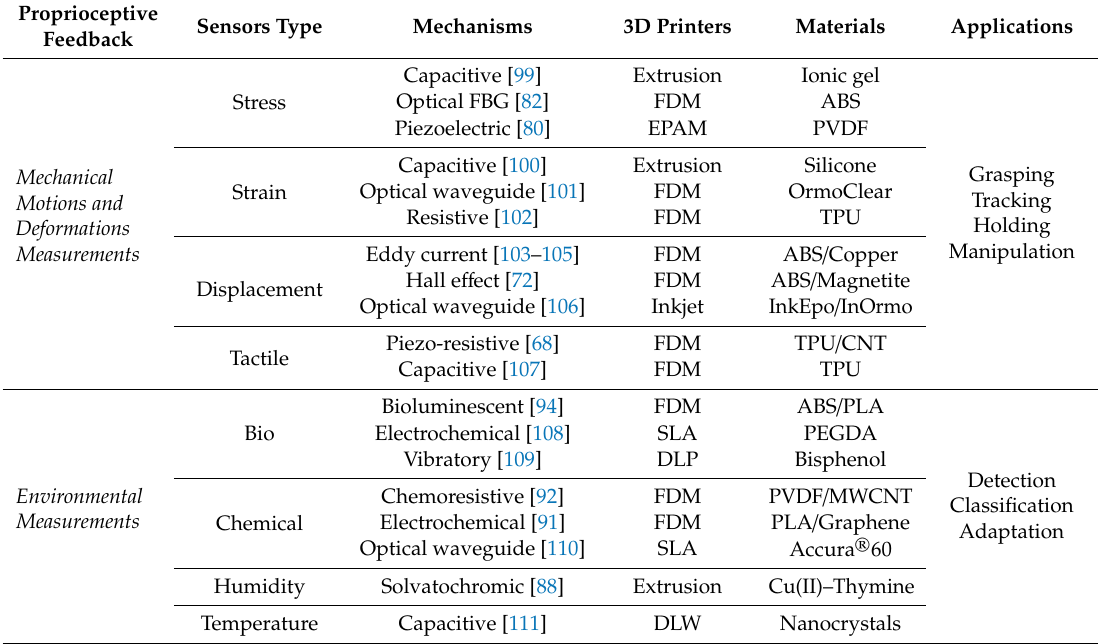
Table 1. Sensors integration into 4D